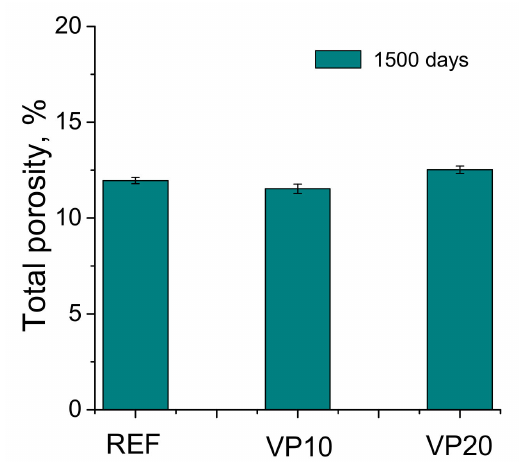
Figure 3. Total porosity results for the analyzed